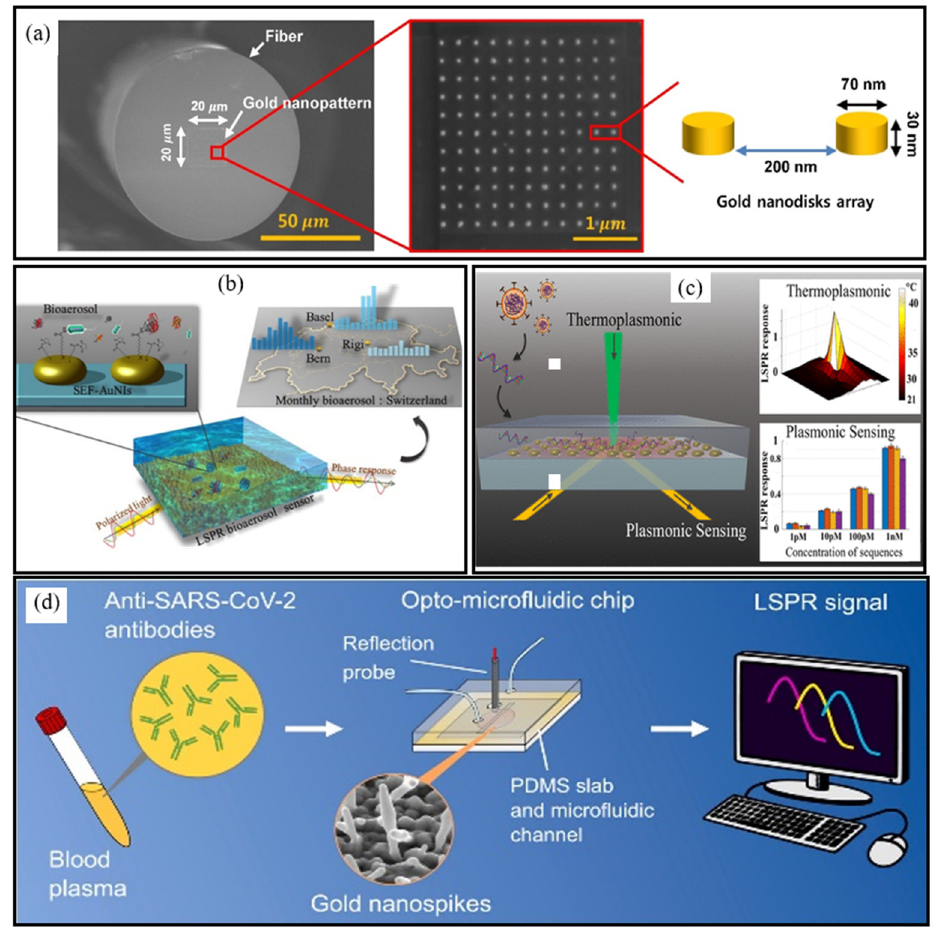
Figure 9. Optofluidic LSPR for the determination of ( a ) prostate specific antigens, ( b ) total bioaerosols, ( c ) sequence of the COVID-19 virus, and ( d ) antibodies against SARS-CoV-2. ( a ) Reprinted with permission from ref [91] Copyright 2019, Elsevier; ( b ) reprinted with permission from ref [53], Copyright 2020, American Chemical Society; ( c ) reprinted with permission from ref [52], Copyright 2020, American Chemical Society; ( d ) reprinted with permission from ref [55], Copyright 2020, Table 4. Comparison of LSPR configuration and sensing performance.